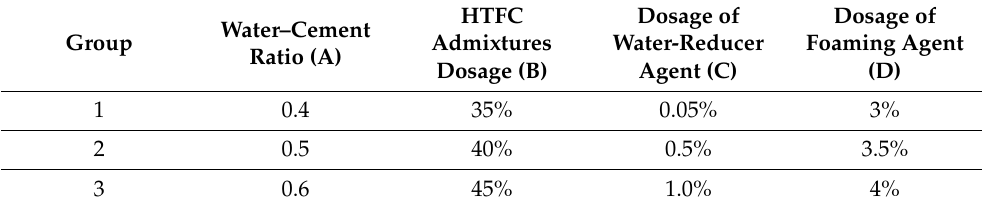
Table 4. Factors and levels in orthogonal